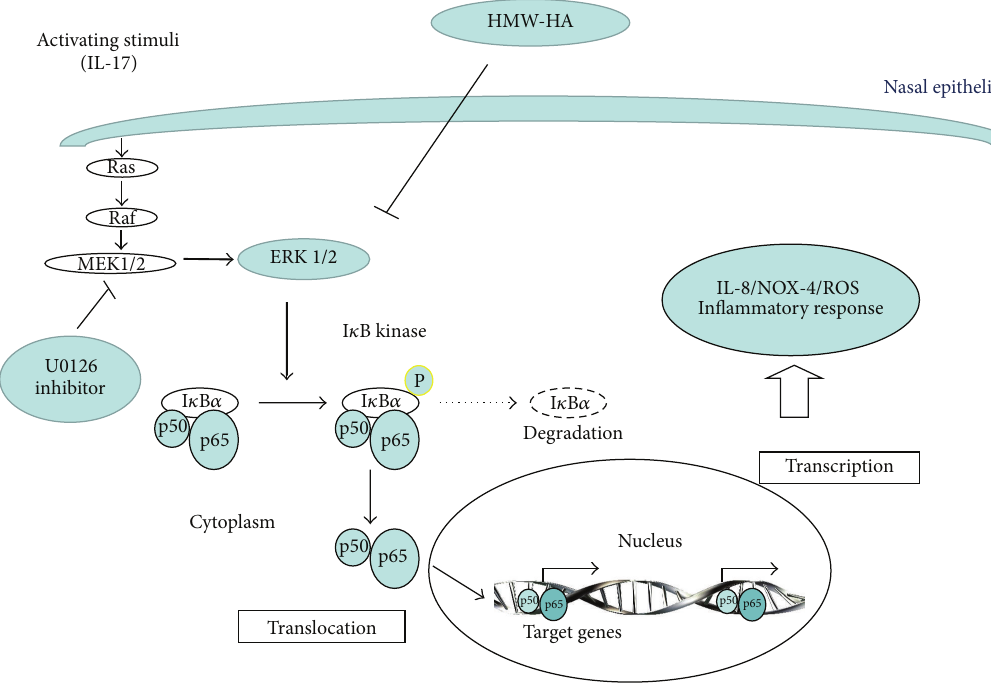
Figure 8: Graphical abstract of the